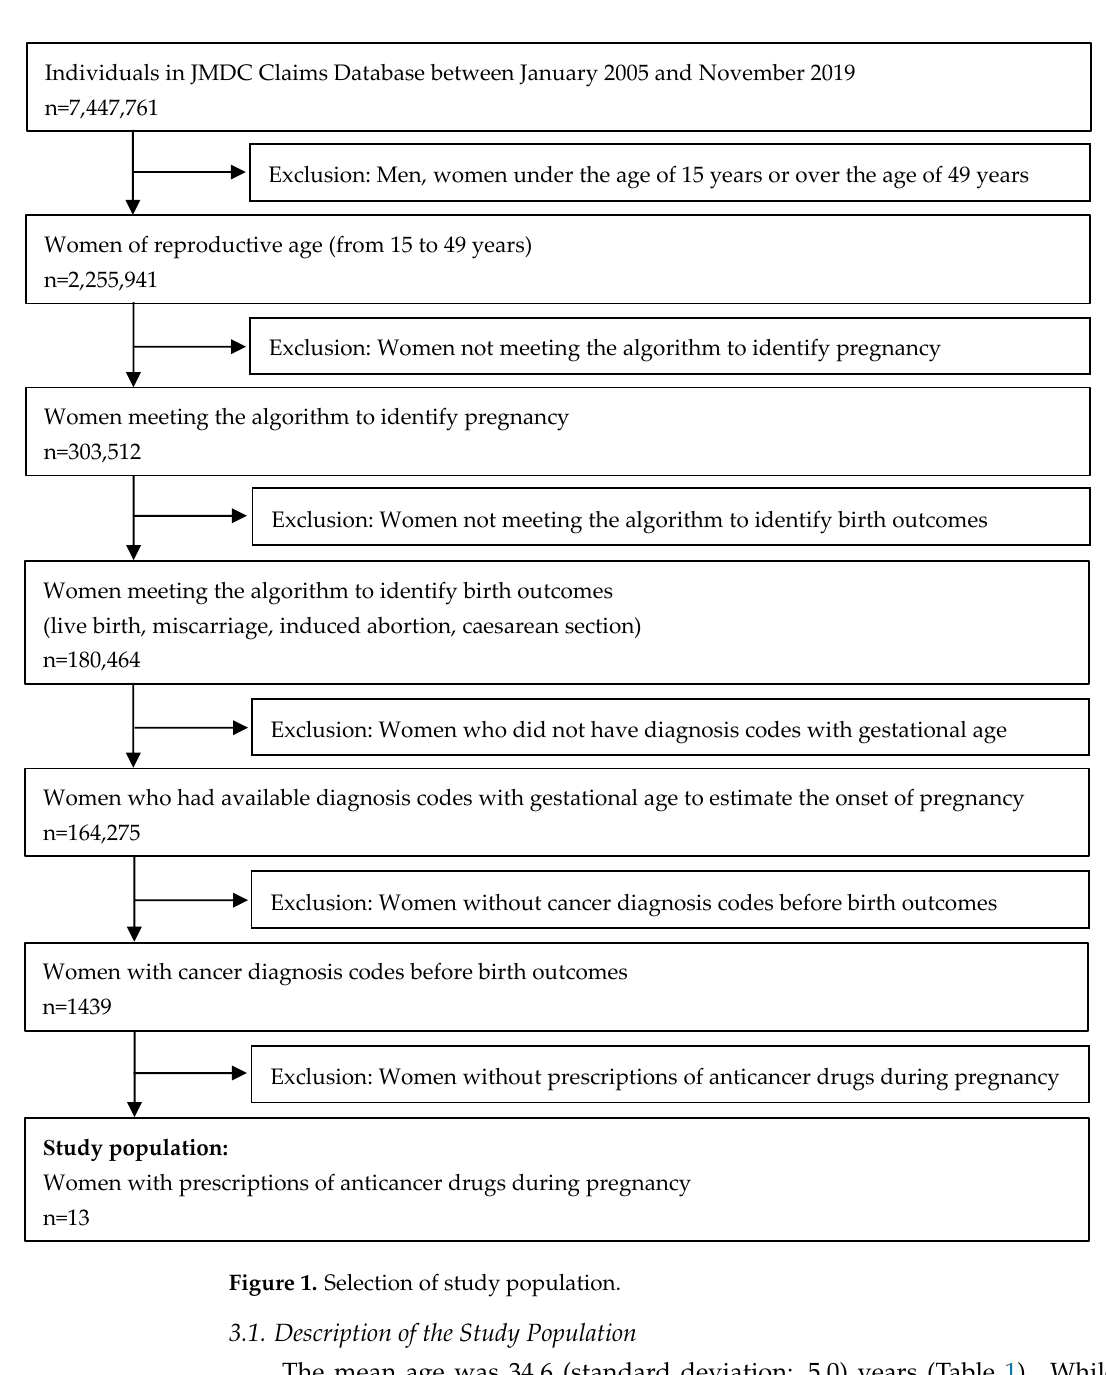
Figure 1. Selection of study population